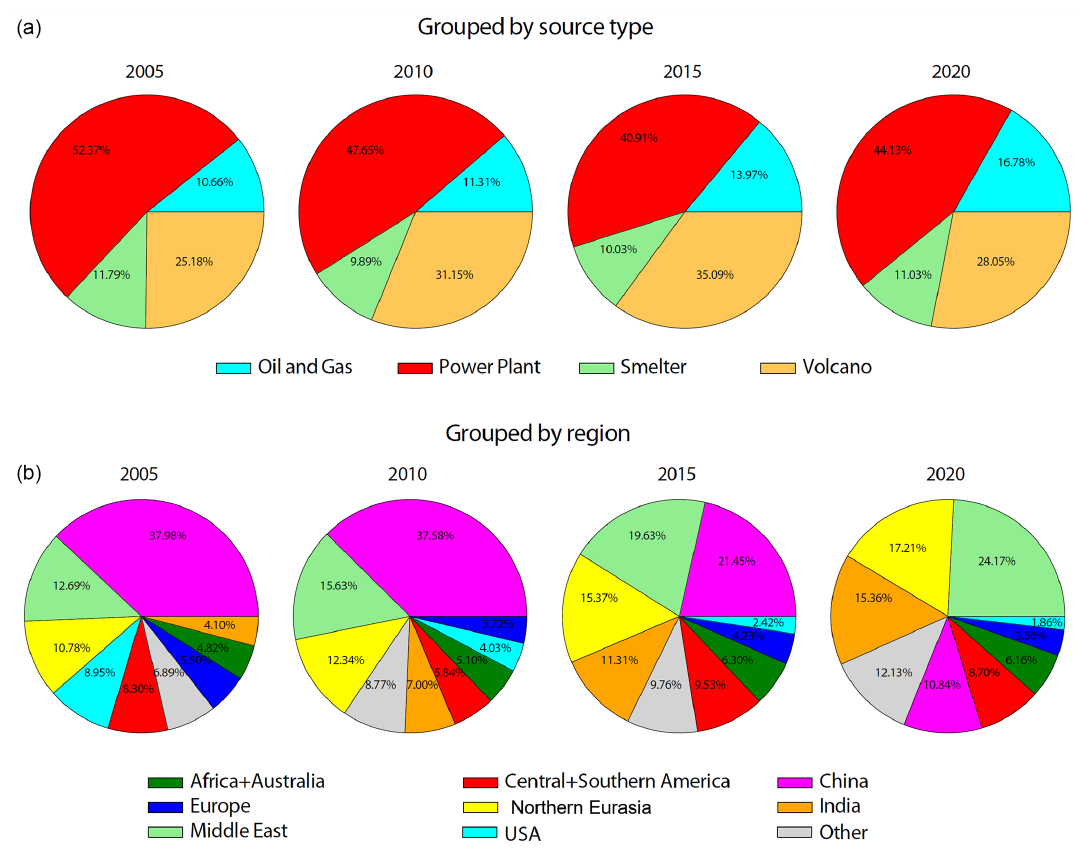
Figure 8. (a) Pie charts of contributions to total SO 2 emissions by the source type. Power plants are the main source of emissions and degassing volcanoes contribute between one-quarter to one-third of total emissions. (b) Pie charts of contributions to total anthropogenic SO 2 emissions by